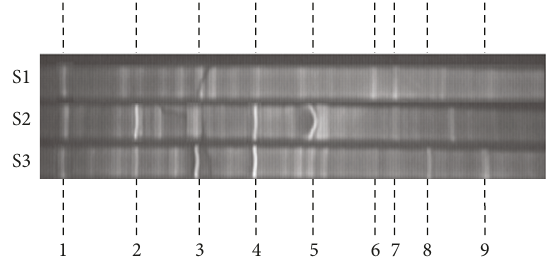
Figure 3: DGGE and on the day 40 (S1), day 80 (S2), and day 150 (S3) (the Arabic numerals meant the di ff erent dominated bands in the operation of MBfR).